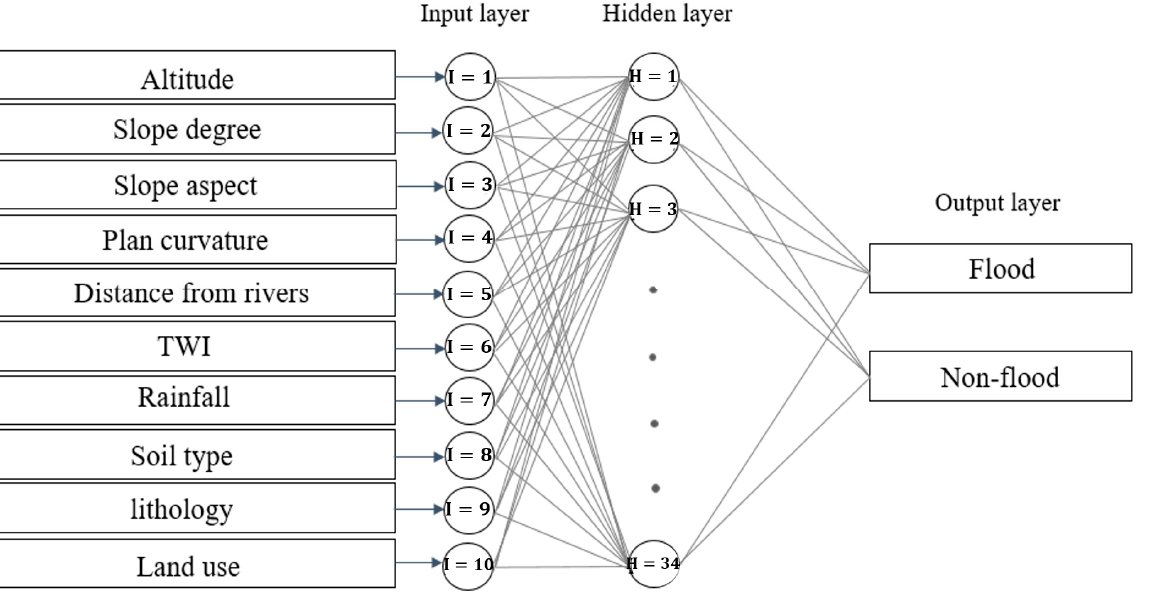
Table 4. Values of statistical measures.